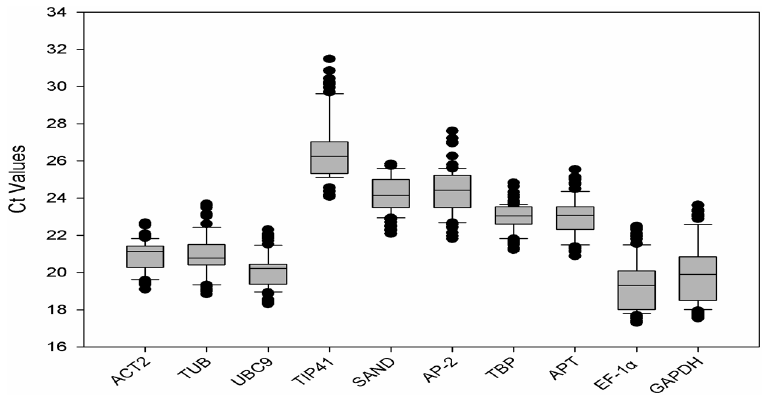
Figure 2. RT-qPCR Ct values for reference genes. Ct values for each reference gene in all Hyperaccumulating ecotype of S. alfredii samples. A line across the box depicts the median. The box indicates the 25% and 75% percentiles, whiskers caps represent the maximum and minimum values, dots represent outliers. doi: